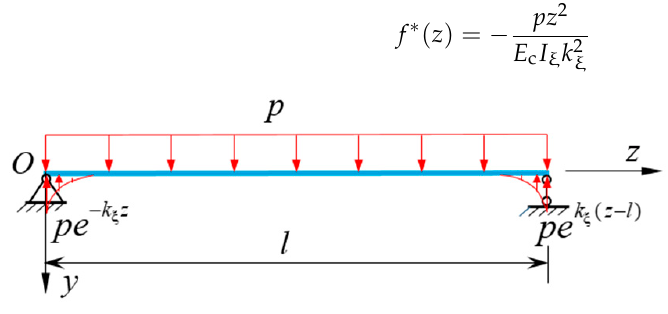
Figure 6. Asimply supported beam. Based on the boundary conditions at both ends and Equation (14), the generalized moment M ξ of simply supported, under uniformly distributed load can be obtained as Equation (31) from Equations (29) and (30):